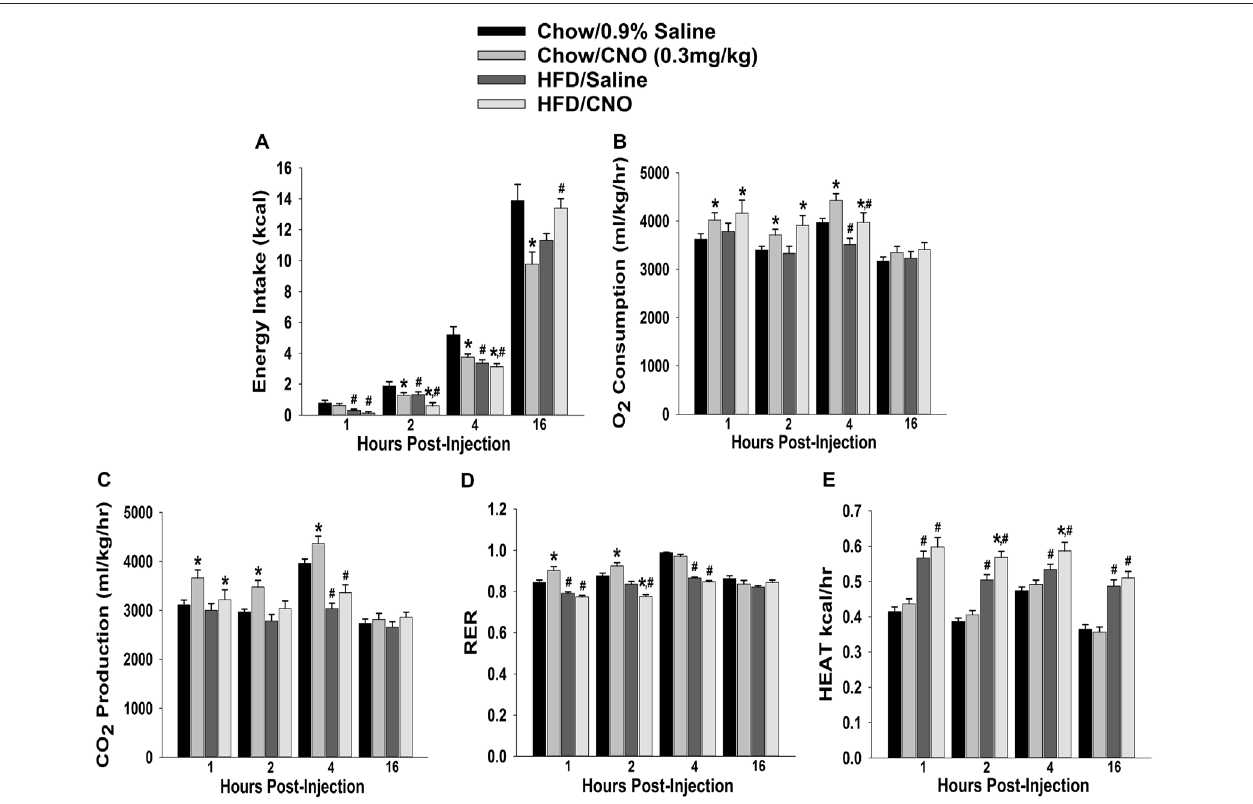
FIGURE 11 | Chemostimulation of VMN SF-1 neurons in male NR5A1-cre mice reduces cumulative energy intake and increases energy expenditure in a diet-sensitive manner. CNO (0.3 mg/kg) significantly decreased cumulative energy intake (A) , and increased O 2 consumption (B) , CO 2 production (C) and RER (D) in chow-fed animals, all of which was significantly attenuated in HFD-fed animals. Conversely, CNO increased metabolic heat production in HFD-fed animals (E) . Bars represent means and lines 1 SEM of the cumulative food intake, O 2 consumption, CO 2 production, RER and metabolic heat production seen in chow- and HFD-fed NR5A1-Cre mice treated with either CNO (0.3 mg/kg; chow: n = 8; HFD: n = 5), or its filtered 0.9% saline vehicle (chow: n = 7; HFD: n = 5). ∗ P < 0.05 relative to vehicle-treated animals; multifactorial ANOVA/LSD. # P < 0.05 relative to chow-fed animals; multifactorial